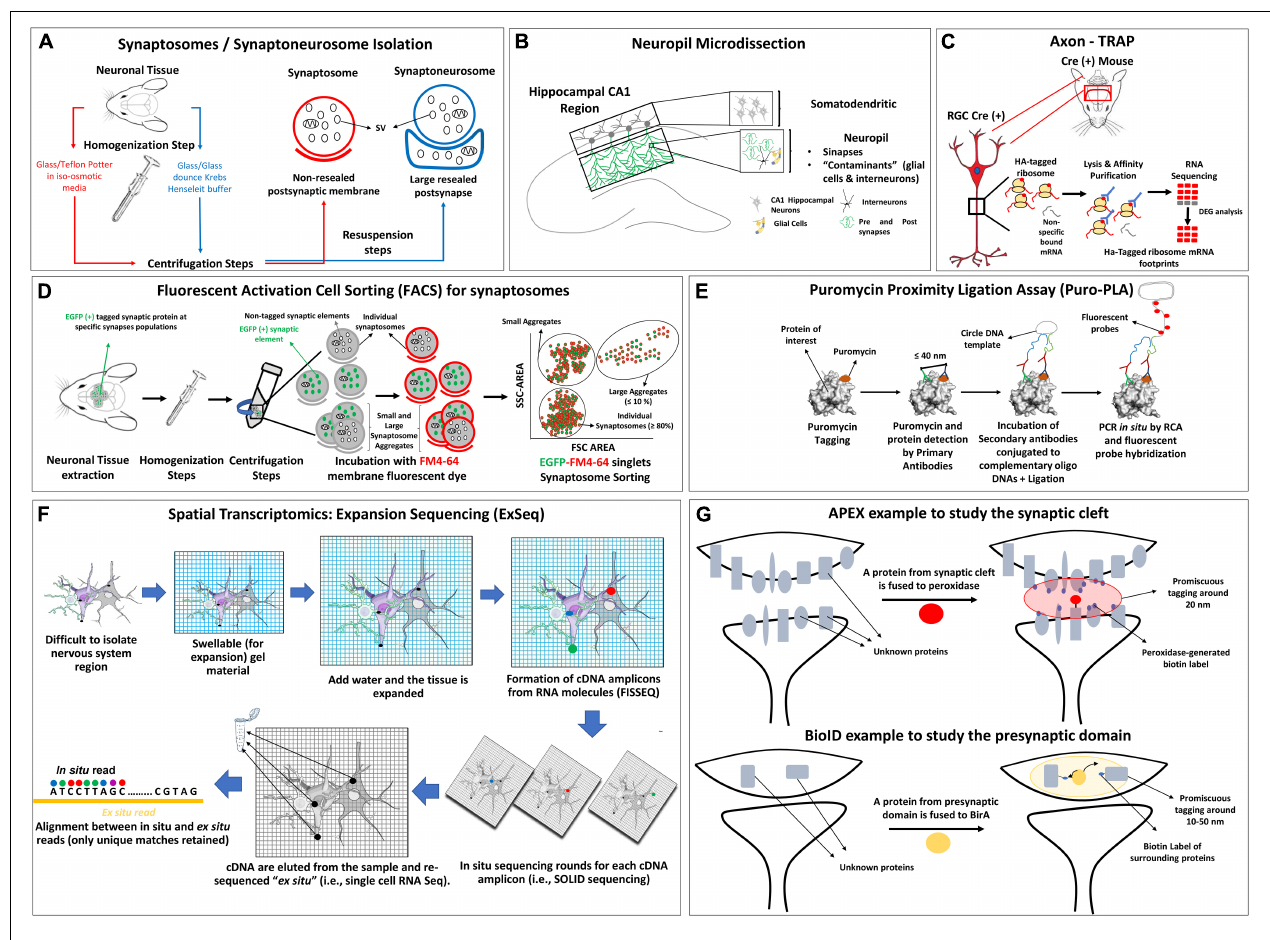
FIGURE 2 | Schemes of synapse isolation protocols compatible with omic approaches including (A) synaptosome and synaptoneurosome, (B) neuropil, (C) axon TRAP, (D) FACS, (E) puromycin proximity ligation assay, (F) spatial transcriptomic example with ExSEQ protocol, (G) APEX and BioID protocols. SV, synaptic vesicle; HA, hemagglutinin; RGC, retinal ganglion cell; DEG, differentially expressed genes; SSC, side-scatter; FSC, forward scatter; RCA, rolling circle amplification; FISSEQ, fluorescent in situ sequencing of